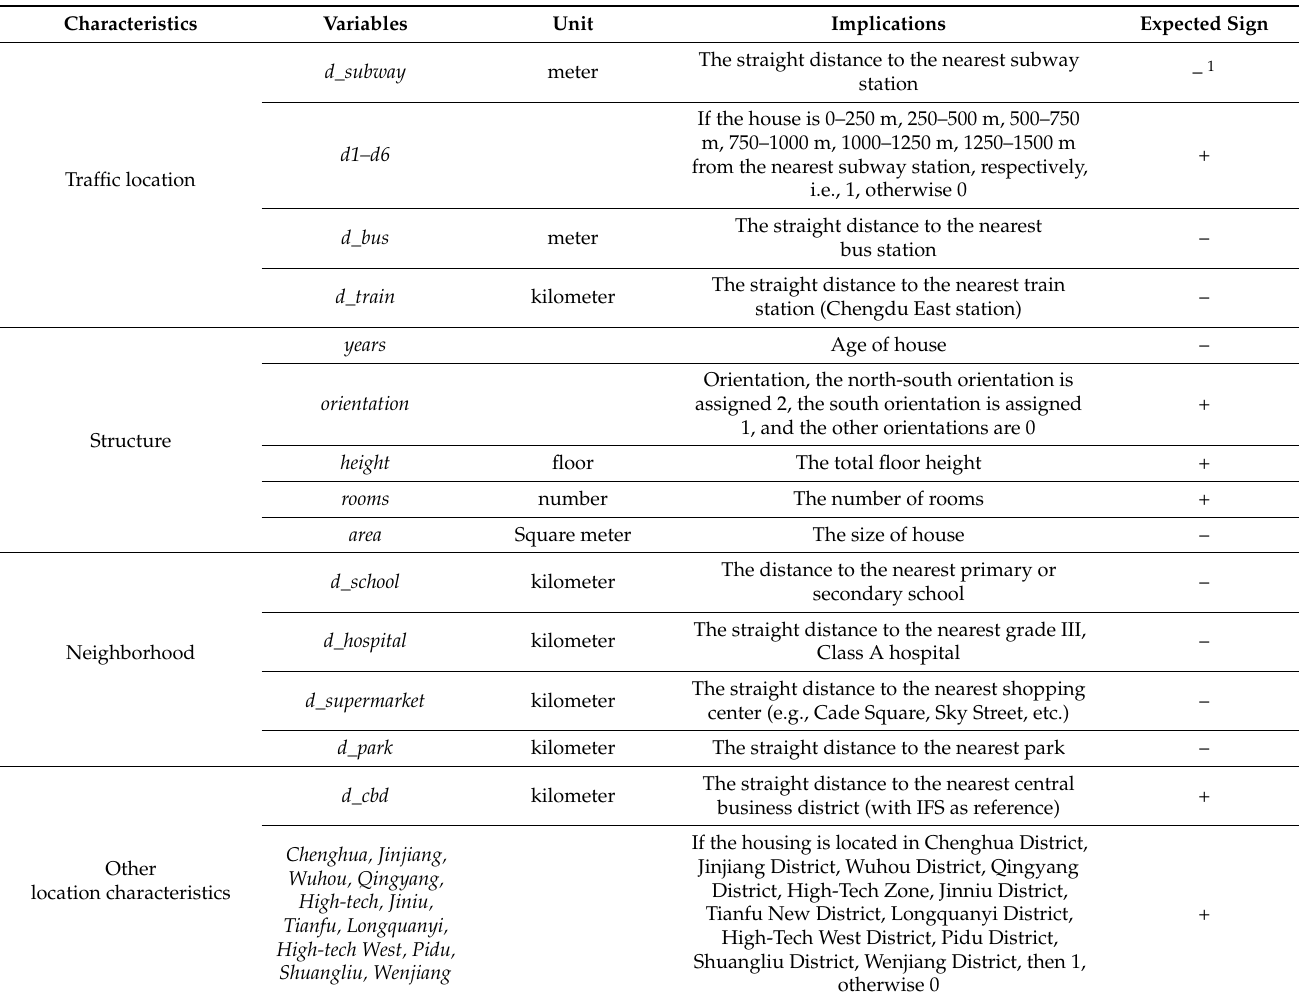
Table 1. Variable unit, description, and symbol of expected